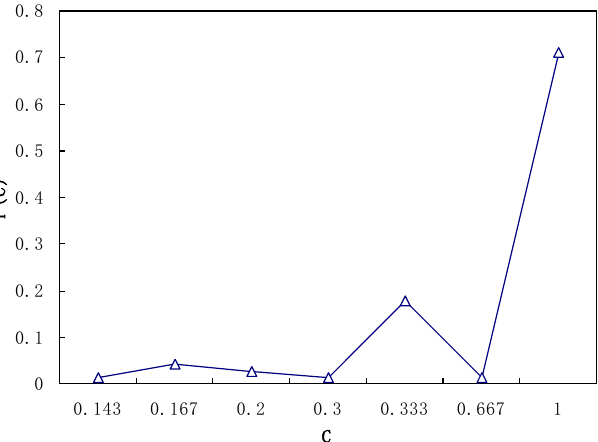
Figure 4. Distribution of sandstone pore network’s clustering coefficient.